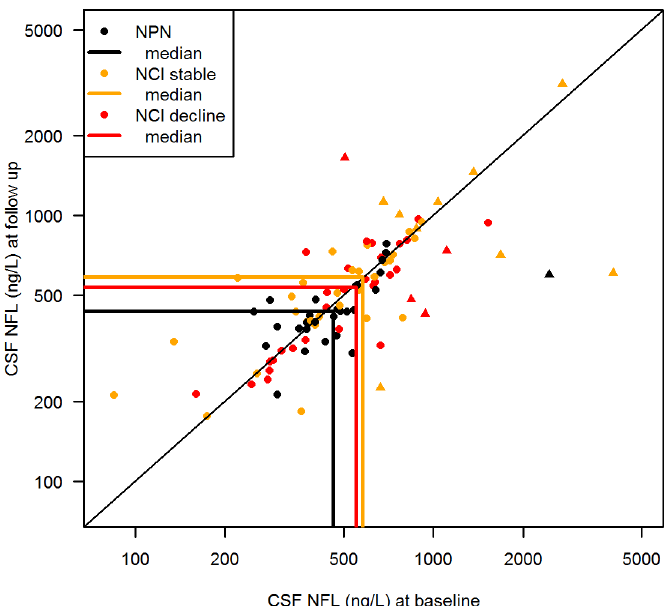
Fig 2. CSF NFL in relation to neurocognitive status and longitudinal stability. CSF NFL at baseline (x- axis) and follow up (y-axis) in neurocognitively normal (NCN) and neurocognitively impaired (NCI) patients (stratified by stability of neurocognitive performance (NP) as NP-stable or NP-decline). Individuals are represented by circles (NFL within age-adjusted normal limits) or triangles (abnormal age-adjusted NFL) and group medians by solid lines. Change in NFL between visits is represented by the distance from the diagonal. Geometric mean CSF NFL was non-significantly higher in neurocognitively impaired (NCI) patients, demonstrated by the difference between the medians (linear mixed effects model; p = 0.27). The proportion of above-normal (triangles) to normal (circles) CSF NFL was higher in NCI patients (19%) than in NCN patients (1%) (Fishers exact test; p = 0.06). CSF NFL in relation to neurocognitive stability was analyzed in the NCI group, where 32/70 patients had a NP-decline (red) and 38 patients were NP-stable (yellow). No difference in CSF NFL was seen between NCI stable and NCI decline subjects, illustrated by the narrow distance between the medians (linear mixed effects model; p = 0.5). Overall, there was no significant change from baseline to follow up in CSF NFL in the treatment groups, demonstrated by the symmetry around the